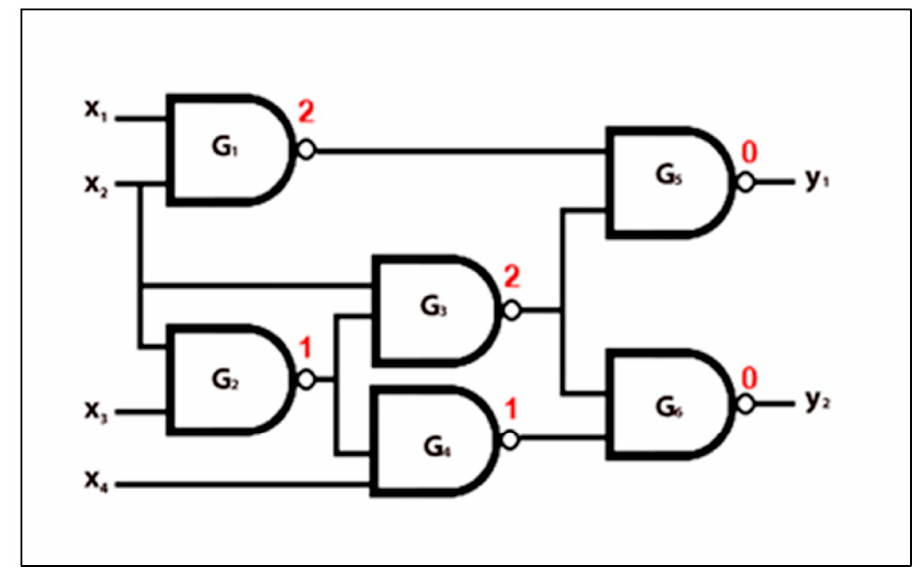
Figure 6. Calculate the degree of convergence.